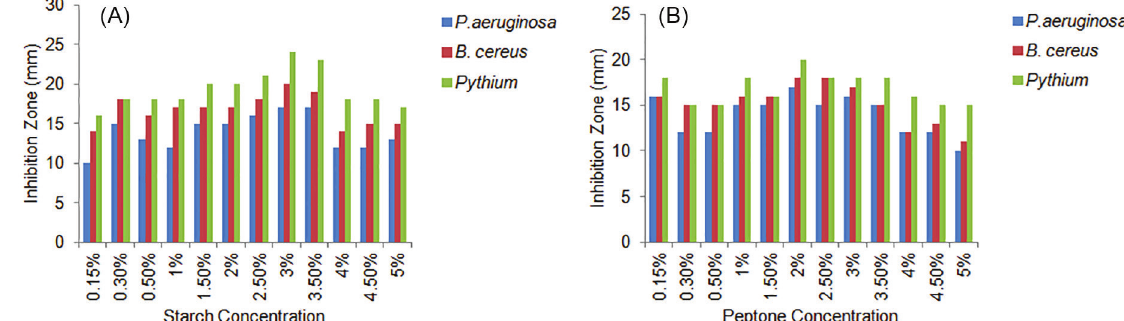
FIGURE 5 - The effect of starch and peptone compositions on the antimicrobial activity of B. subtilis subsp. subtilis str. 168 against different